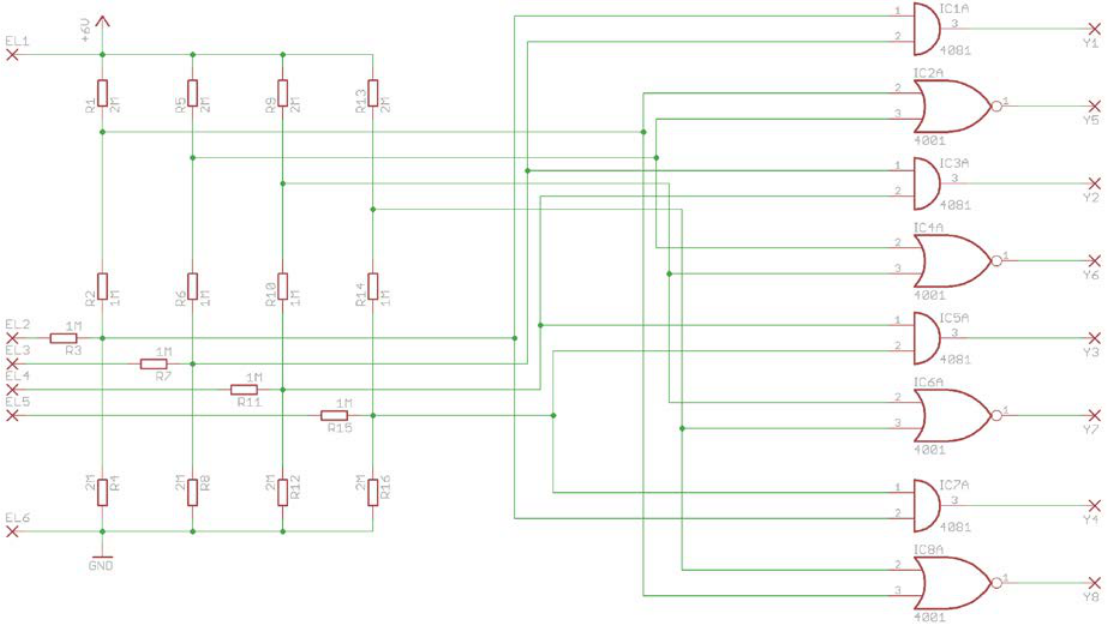
Figure 15. Logic circuit for the sensor in the form of the cuboidal sensor presented in Figure 12a: EL1–EL6, electrodes of the sensor; Y1–Y8, digital outputs corresponding to particular vertices .